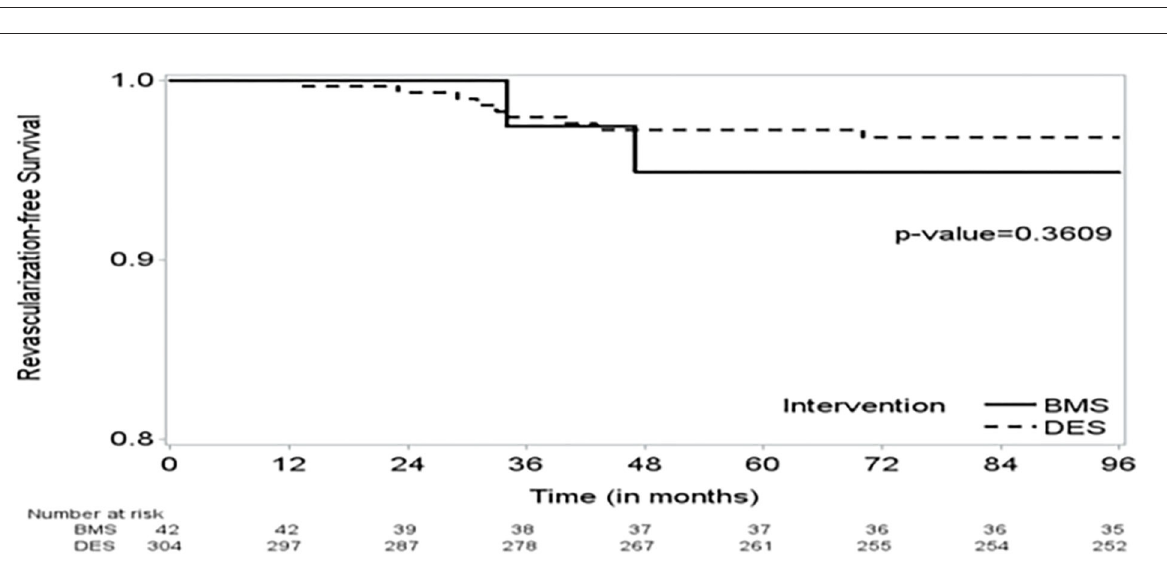
statistical significance. For data analysis, SAS version 9.4 (SAS Institute, Inc., Cary, North Carolina) was